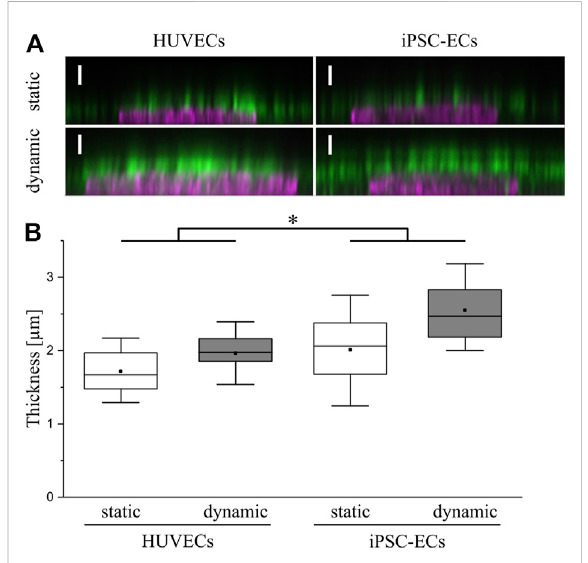
FIGURE 6 Determination of glycocalyx thickness on HUVECs and iPSC- ECs after 96 h of static and dynamic culture. (A) Representative confocal images of chondroitin sulfate (green) and nuclear staining (magenta) shown as orthogonal projection (Scale bars: 2.5 µm) to determine (B) the glycocalyx layer thickness. Data are presented as box plots including mean, median and 90% con fi dence interval. Signi fi cant differences were found between overall HUVEC vs iPSC-EC samples as well as between overall static vs dynamic samples deployed as the main factors ( n = 4, two-way ANOVA: main factors, * p < 0.05). Comparing single conditions the only signi fi cant difference was found between HUVEC static vs iPSC-EC dynamic ( p < 0.006).